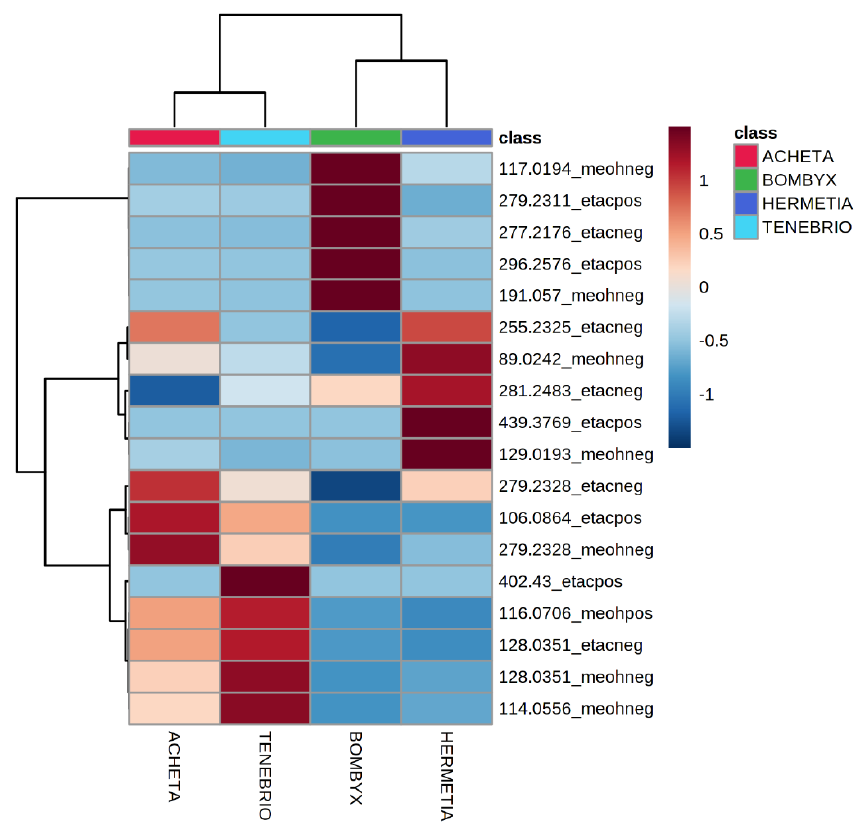
Figure 5. Heatmap (Pearson distance, Ward clustering algorithm) shows the correlation between selected informative variables ( m / z ) and different insect powders. The acronym “etacpos” indicates that the informative variable was retrieved from the dataset obtained by the analysis of the extract B in positive ion mode; the acronym “etacneg” indicates that the ion was retrieved from the extract B analyzed by negative ion mode; the acronym “meohpos” indicates that the informative ion was extrapolated from the dataset of the extract A analyzed in positive ion mode; the acronym “meohneg” indicates that the informative ion was selected from the dataset obtained by the analysis of the extract A in negative ion mode. Table 1. List of discriminant (±) DART-HRMS compounds that enable the identification of the four species of insects. The observed m/z , theoretical m/z , error (ppm), elemental formula, type of ion, and tentative assignment are listed.